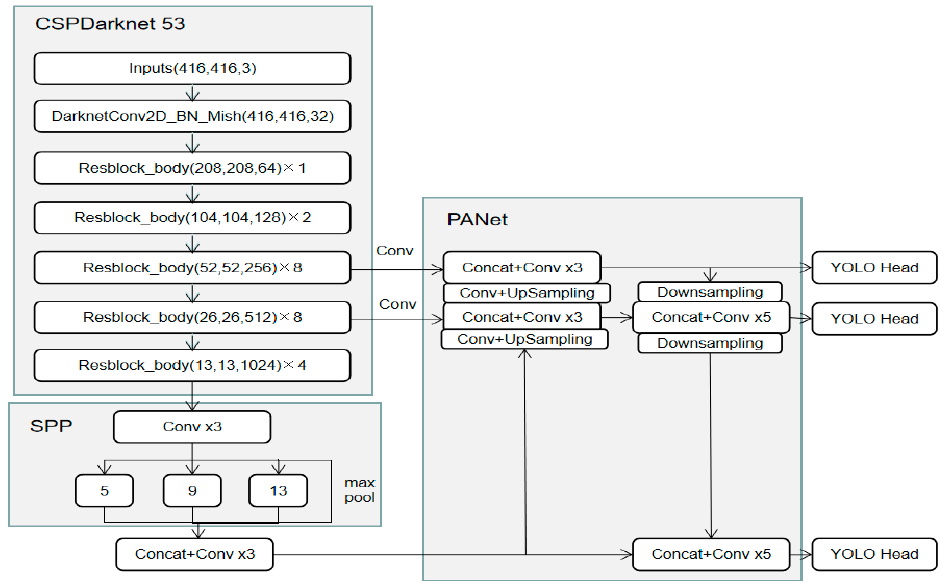
Figure 1. Structure of